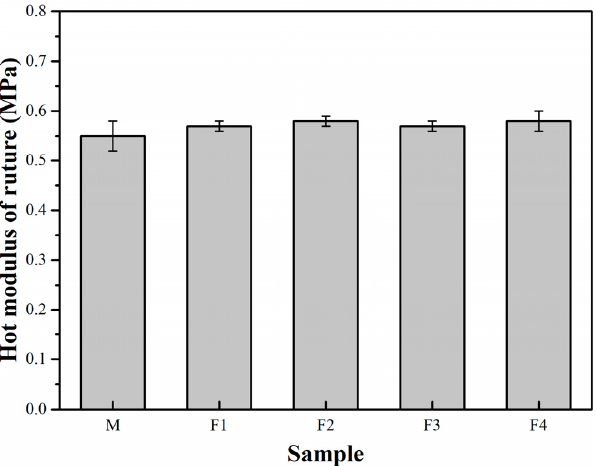
Figure 9. HMOR of the castable specimens after heat treatment at 1450 °C for 3 h.